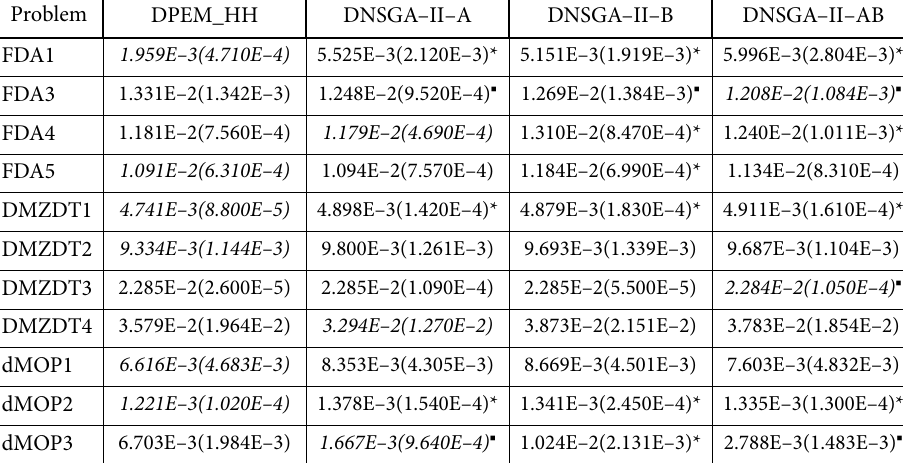
Table 2. Offline mean and standard deviation of IGD metric for DPEM_HH and all DNSGA–II versions